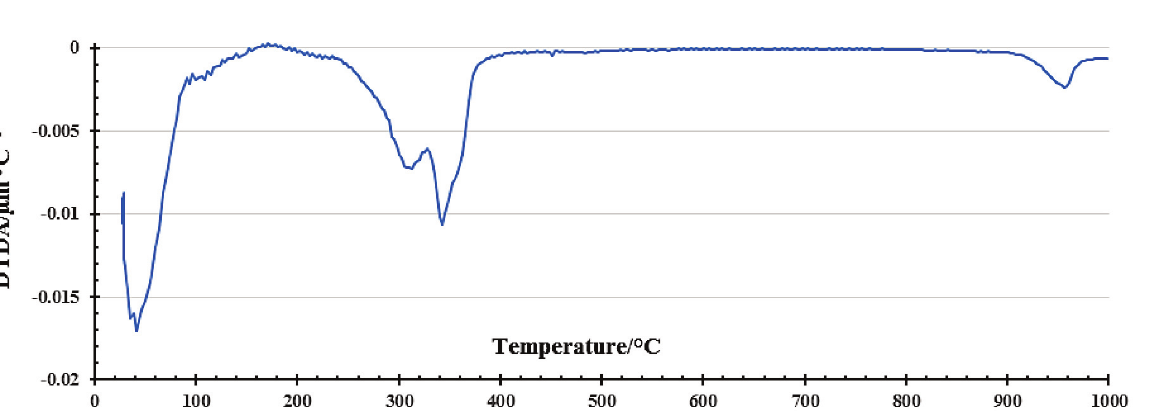
Fig. 3. Heating curve (DTDA-diagram) of CA.